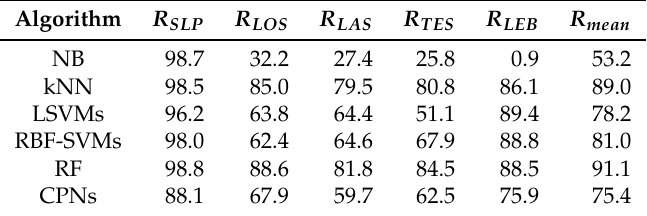
Table 3. Comparison results of learning algorithms [%].